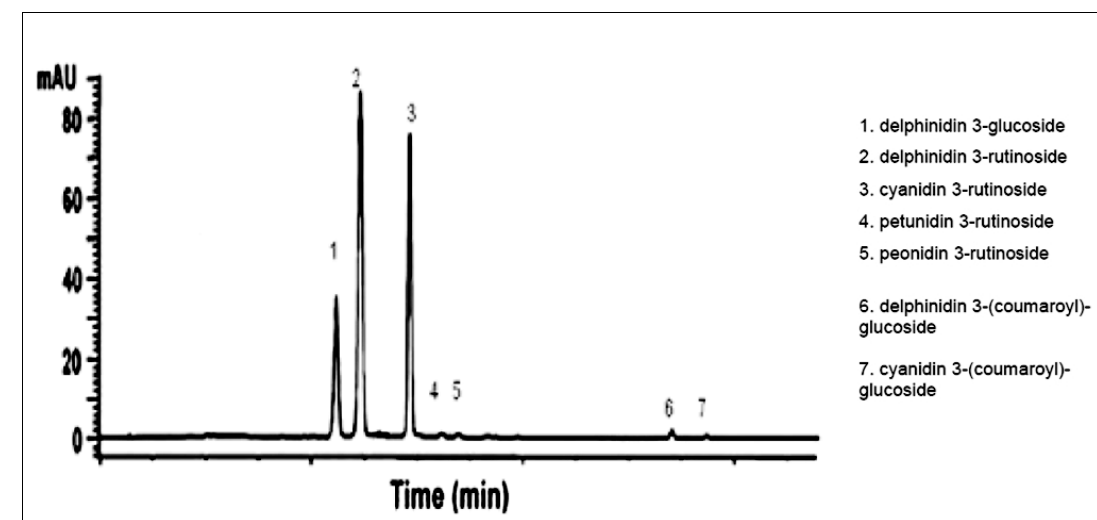
Fig. 2: HPLC separation of anthocyanins detected at 520 nm from black currant (cv Royal de Naples). Peak assignment is provided on the right